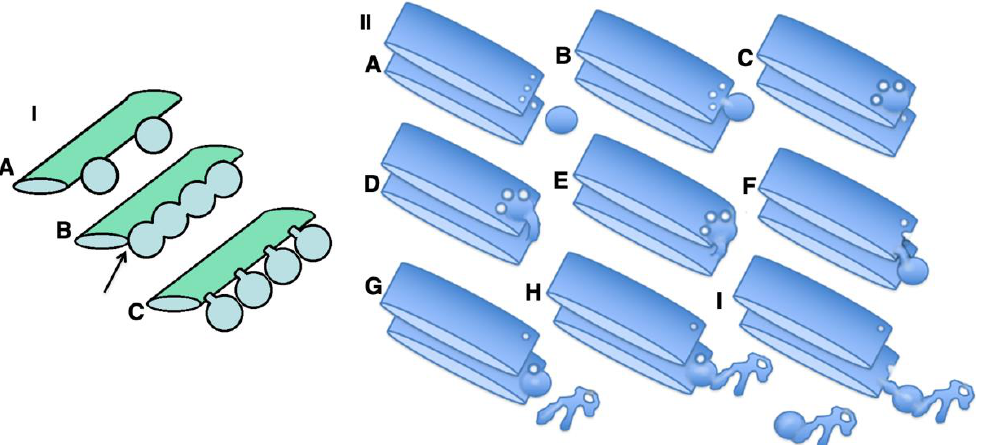
Figure 15. Scheme demonstrating the mechanism of IGT according to the KARM. ( I ). Formation of the cargo ribbon. ( A ) Arrival of two cargo domains. ( B ) Arrival of new domains and their fusion, leading to the parallel ribbon. ( C ) Budding of the cargo domains from the Golgi cisternae. ( II ). ( A ) The asymmetric KARM (carrier maturation) poses that a cargo domain (sphere in the upper-left image fuses with the cisternal rims containing several pores. This is shown in ( B,C ). ( D , E ) The cargo domain fuses with the distal cisterna with the tubule. ( F ) Break of the tubules within the zone where pores were situated. ( G ) Fission of the tubule connecting the cargo domain and the proximal cisterna. ( H , I ) Arrival of the trans-Golgi network, its fusion with the cargo domain, and the consecutive fission of the tubule connecting the cargo domain and the distal cisterna.